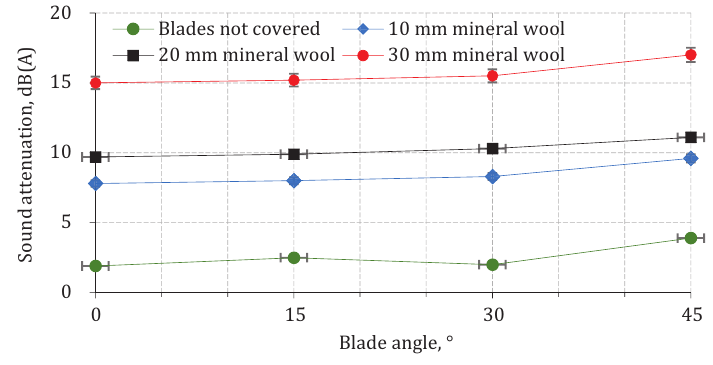
Figure 14. Comparison of the change in equivalent sound pressure